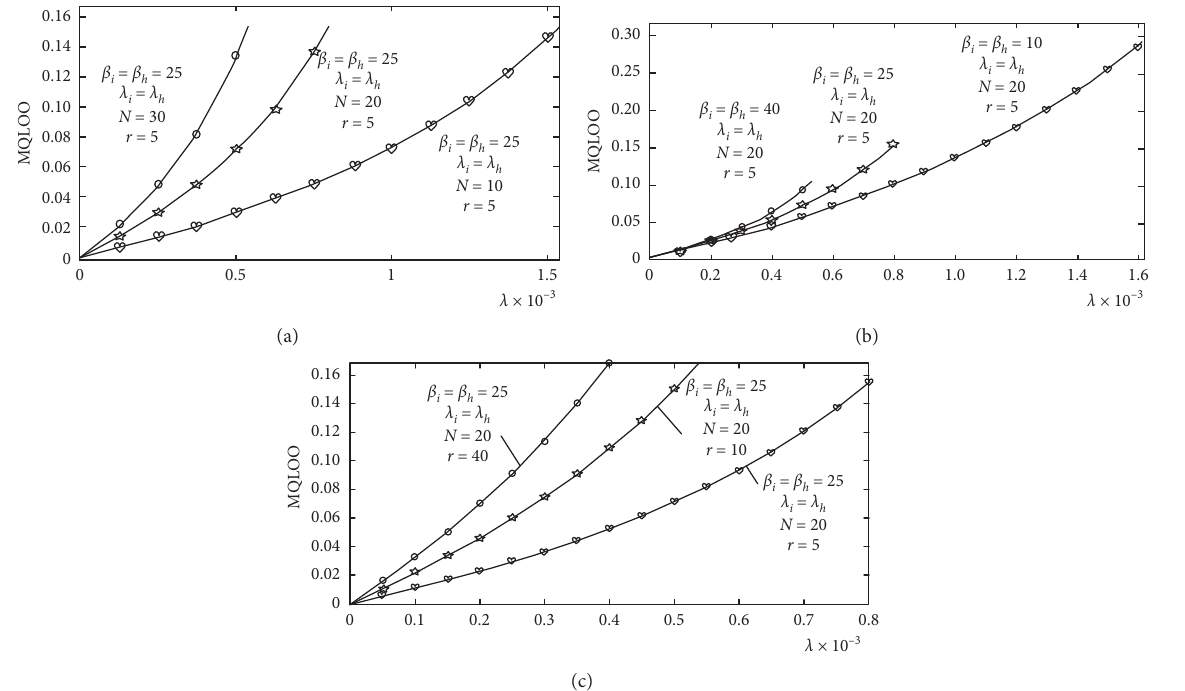
Figure 3: The change trend of the MQLOO. (a) Range of MQLOO with λ ′ s change under different N . (b) Range of MQLOO with λ ′ s change under different β. (c) Range of MQLOO with λ ′ s change under different r .